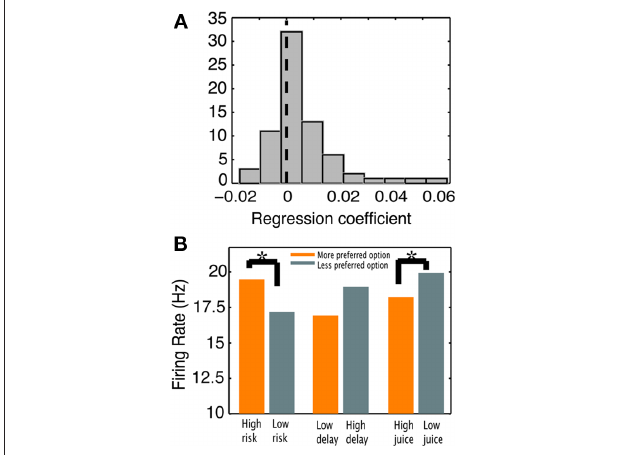
Figure 6 | Firing rates of Cgp neurons track decision salience. (A) Histogram of regression coefficients for firing rates as a function of choice salience for all neurons in the population. (B) Average population response was significantly higher for choosing high risk (versus low risk) and low juice (versus high juice) options. Higher firing rates were associated with options more different from the